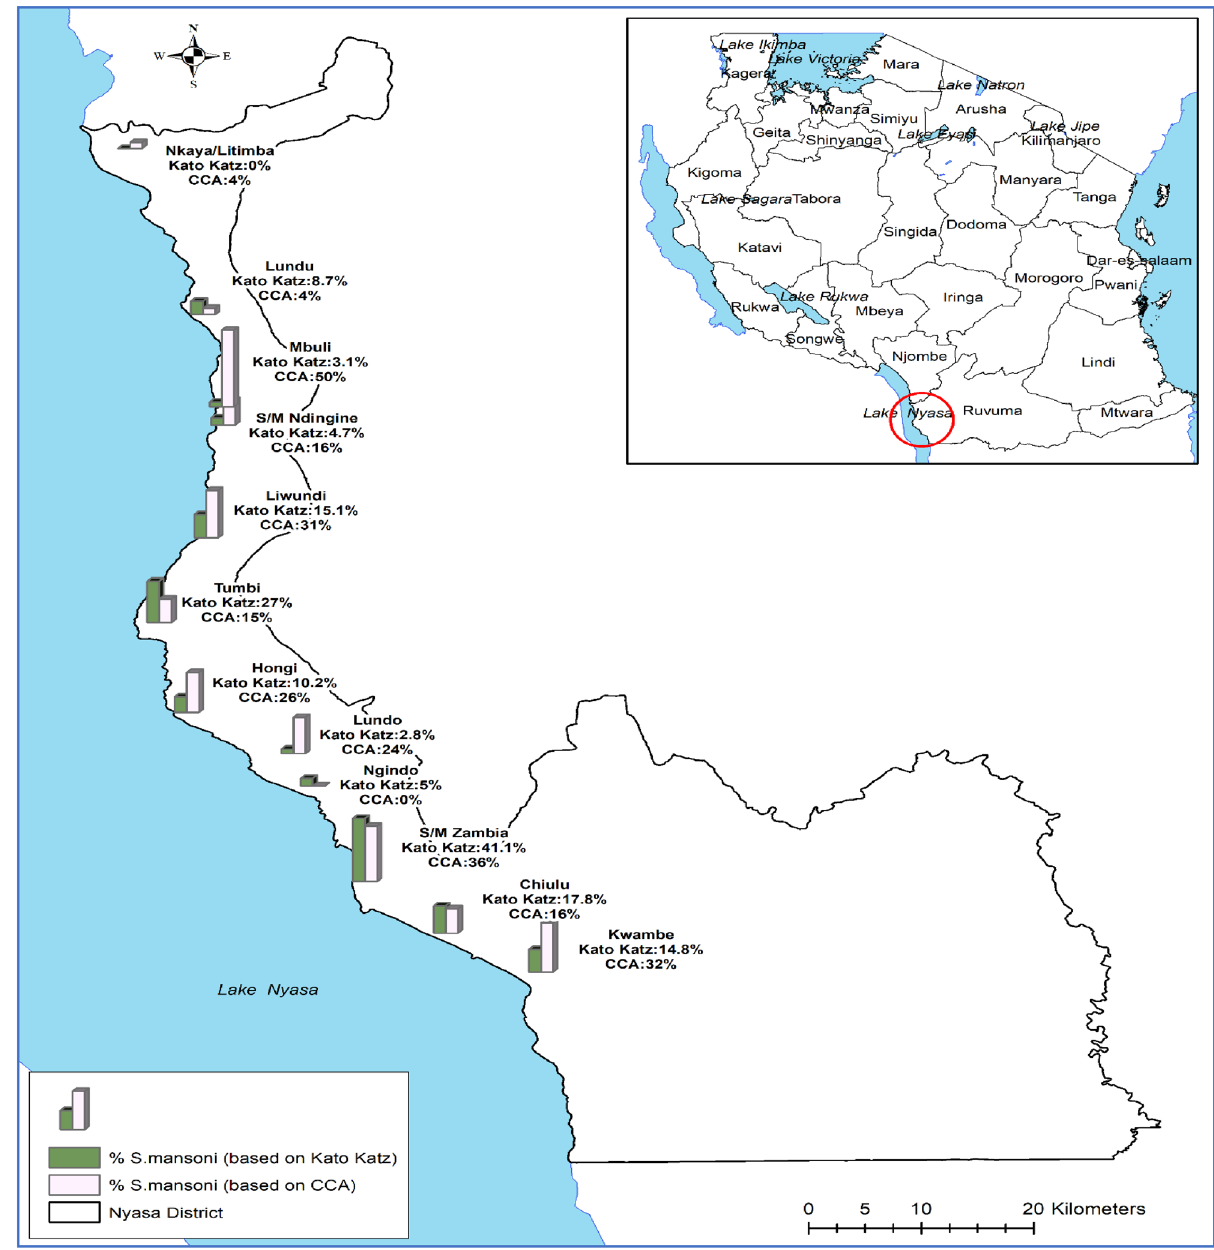
Figure 4. Geographical prevalence of Schistosoma mansoni based on Kato Katz technique and point-of-care circulating cathodic antigen tests in villages surrounding Lake Nyasa, Southern inland communities 23 , in Tanzanian side of the same lake, S.haematobium transmission is very low but the area maintain high transmission of S. mansoni . Perhaps, transmission of S. haematobium in the area surrounding Lake Nyasa occurs more on the inland areas compared to lakeshore areas. The present study did not include the inland communities located out of the lake shorelines and malacological surveys were not done. The inclusion of these areas could have given a different picture of S. haematobium and S. mansoni transmission levels in the district. This call for a follow-up study. On the other hand, all children identified to be infected with S. haematobium were aged > 6 years and major- ity had low infection intensities. Supporting evidence from previous studies which have reported that children aged > 6 years remains at high risk of S. haematobium than the youngest age groups 43 . This can be explained by increased duration and frequencies of human-water contact activities among the members of the age group which exposes them to infection 43 . The absence of S. haematobium infection in children under five in the pre- sent study can also be explained by a low transmission of S. haematobium in the study setting or limitation of parasitological techniques to identify children with low infection intensities, which is common observation in children under-fives 42 . In sub-Saharan Africa, S. haematobium infection has been noted to start at young